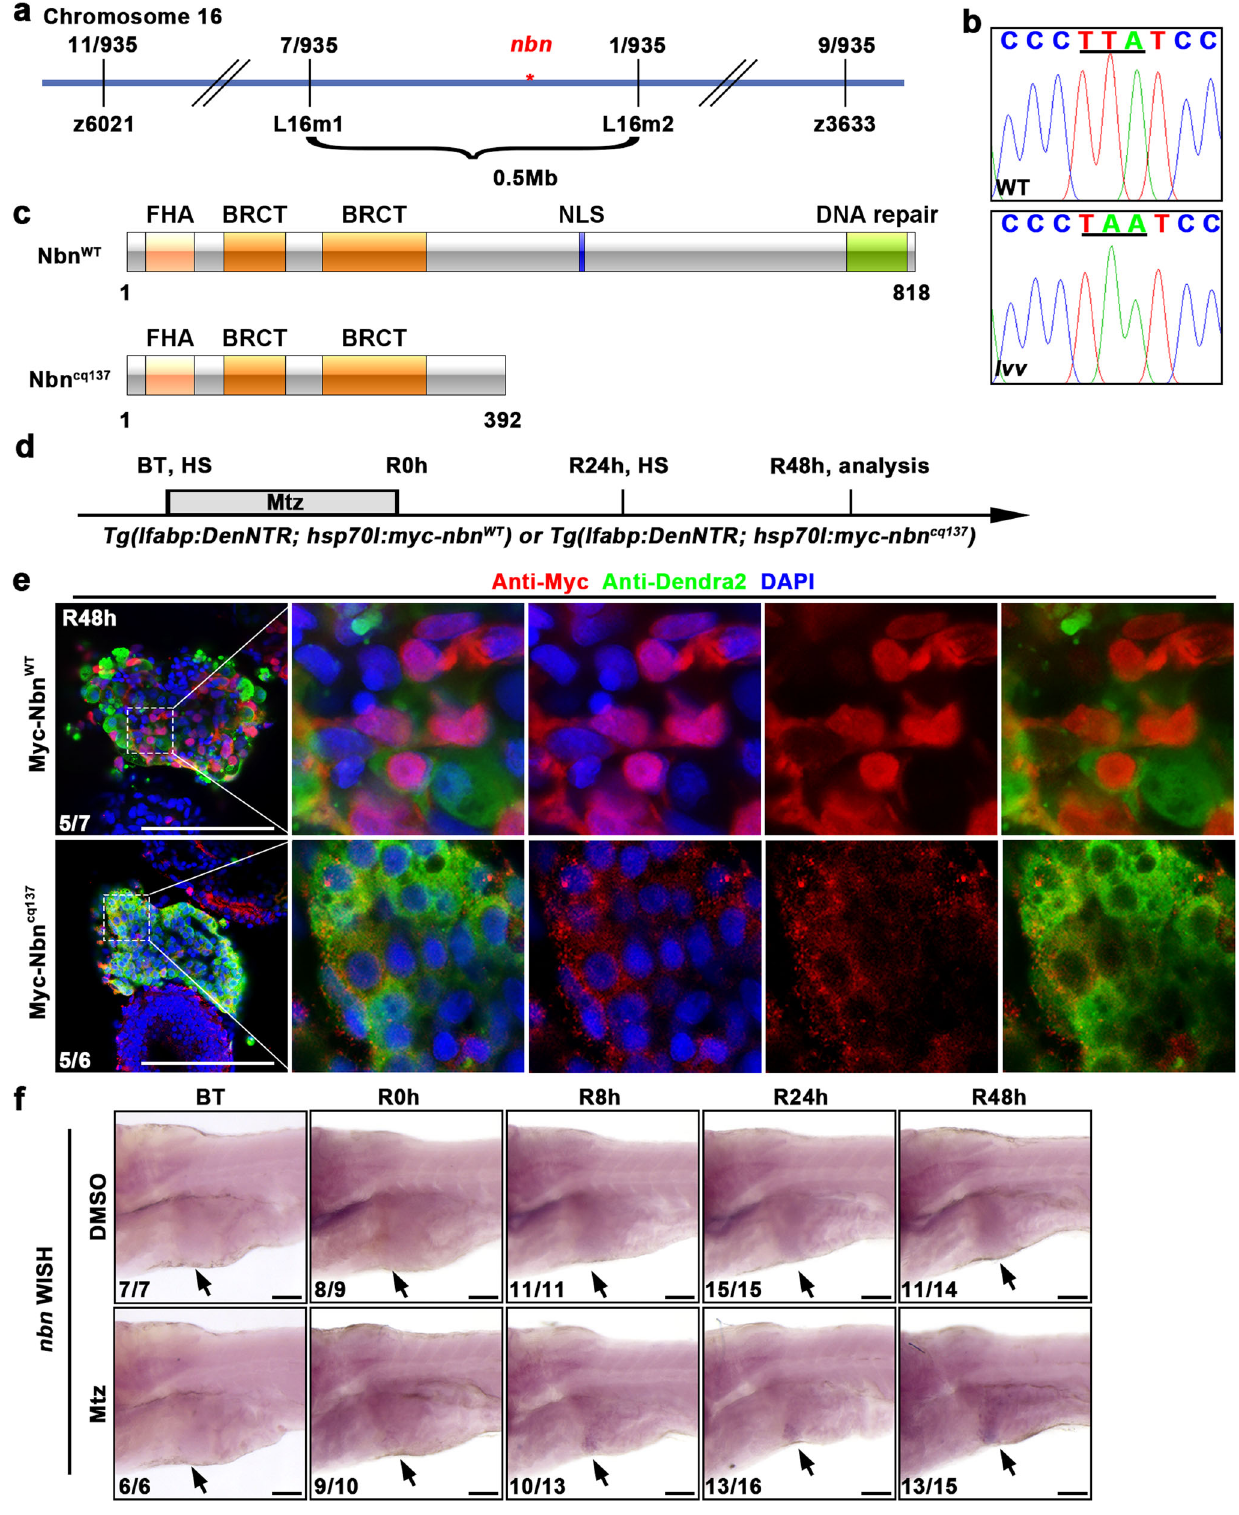
Fig. 2 nbn is the mutated gene of lvv mutant. a Genetic map of the candidate region on chromosome 16. Numbers above SSLP markers indicate recombination events. b Sequencing results displaying the mutation site in nbn . c Schematic diagram of the structure of Nbn protein. FHA, BRCT, and NLS denote forkhead-associated domain, BRCA1 C-terminal domain, and nuclear localization signal, respectively. d Schematic illustration of Mtz treatment and analysis at R48h. e Single optical section images showing Myc (red), Dendra2 (green), and DAPI (blue) staining in regenerating livers at R48h under the Tg(lfabp:DenNTR) background. Note that Myc-tagged Nbn WT is mainly localized in the nucleus, while Myc-tagged Nbn cq137 is localized in the cytoplasm. f WISH images showing nbn expression in the liver region (arrows) from BT to R48h. Numbers indicate the proportion of larvae exhibiting the expression shown. Scale bars, 100 μ m. WT wild-type, DAPI 4 ′ , 6-diamidino-2- phenylindole, BT before Mtz treatment, R regeneration time after the withdrawal of Mtz, WISH whole-mount in situ